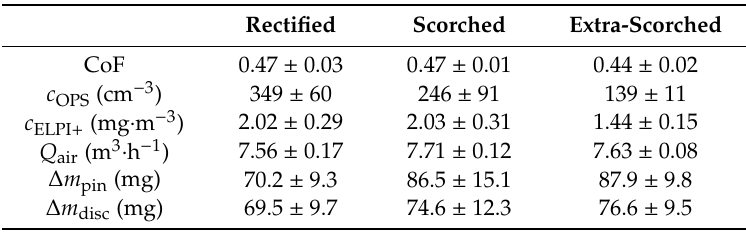
Table 4. Mean value and standard deviation of the measured CoF, particle concentration, air flow rate and mass losses of the pin and disc samples.